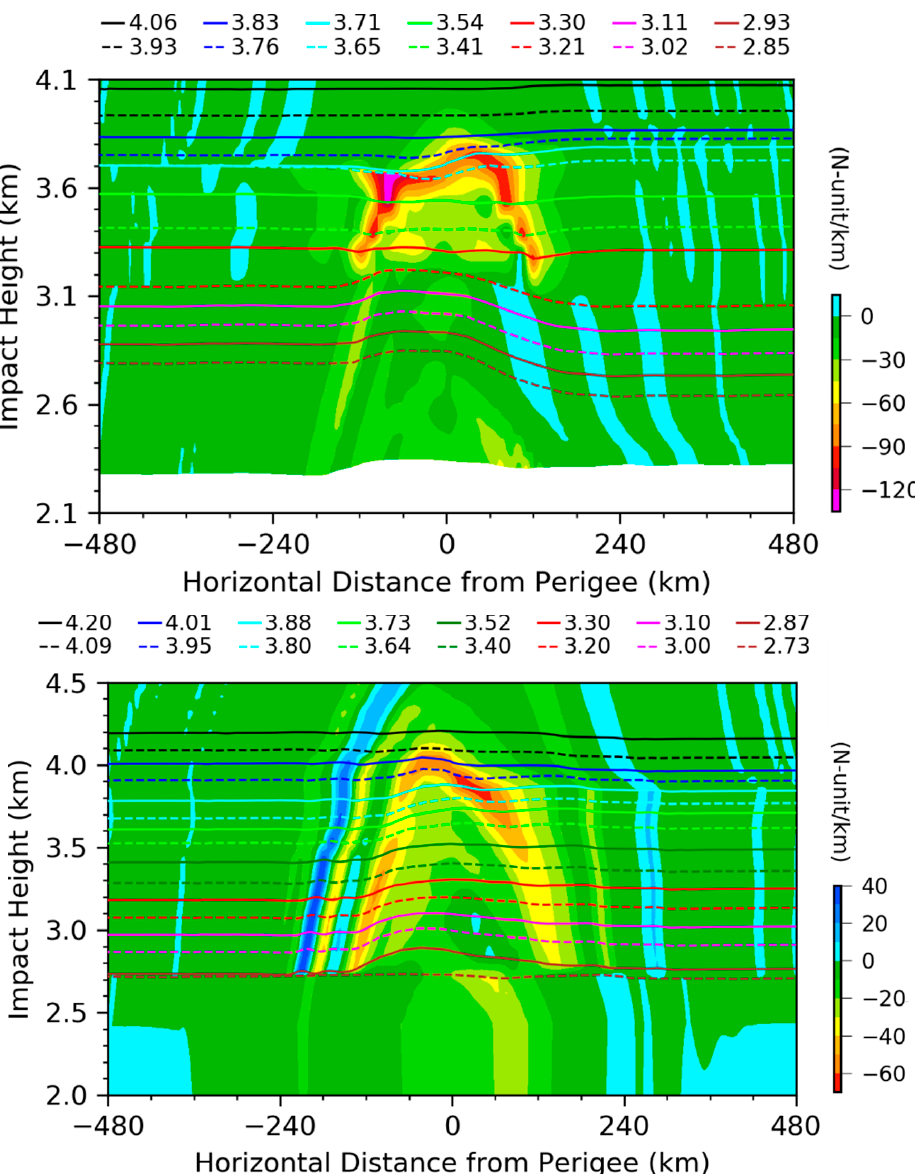
Figure 5. Impact heights of all 16 simulated ray paths (solid and dashed curves) and vertical gradient of N wet ( N -unit km − 1 , shaded in color) for RO1 ( top panel ) and RO2 ( bottom panel ). The impact heights of rays at the perigee points (in km) are indicated at the top of each panel.